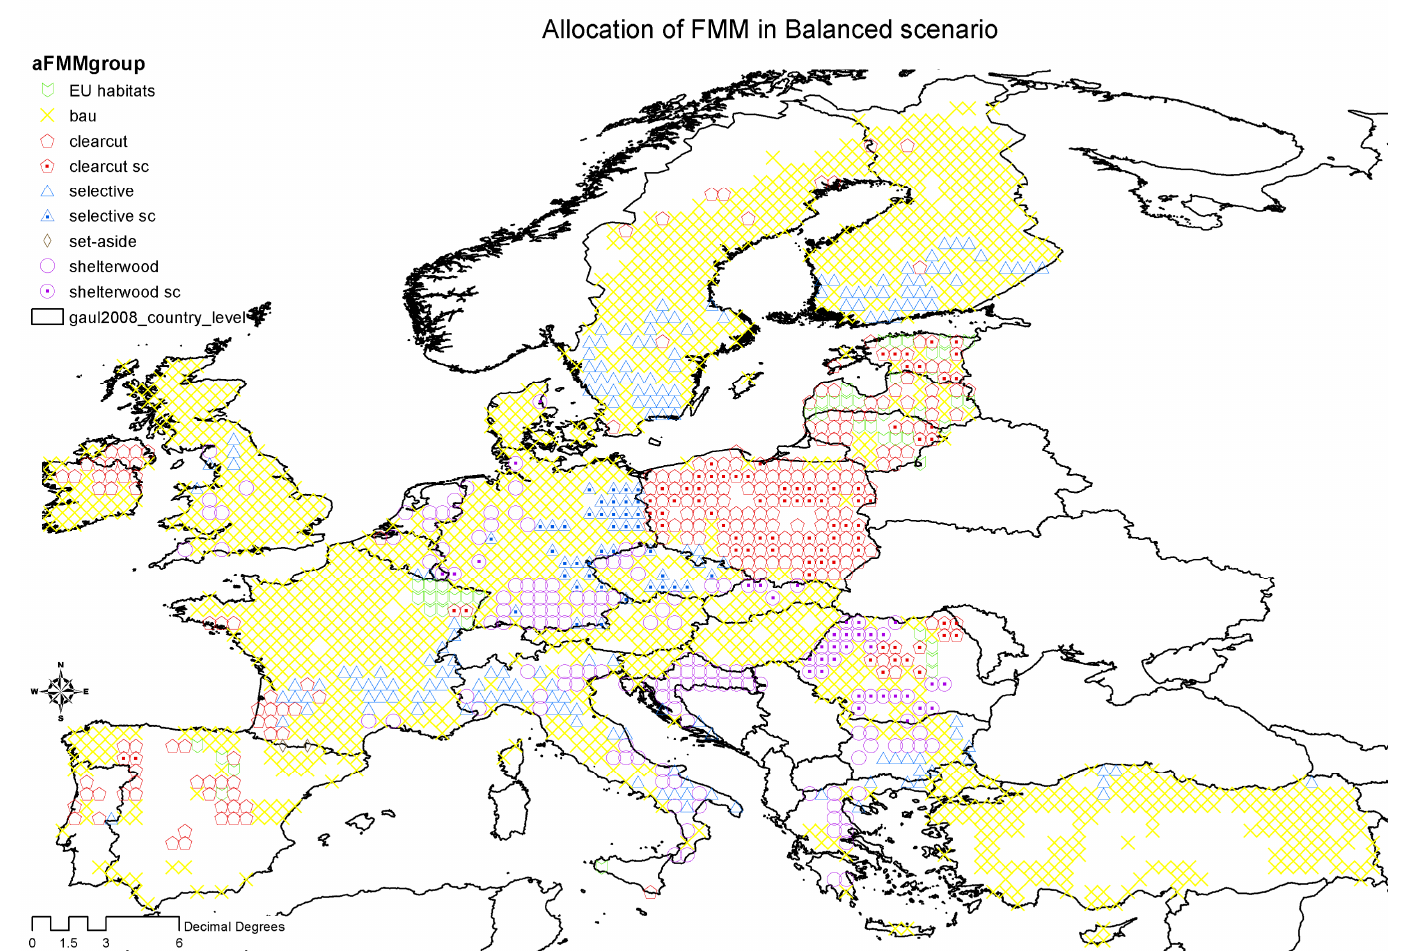
Figure A1. Allocation of the forest management models in the balanced